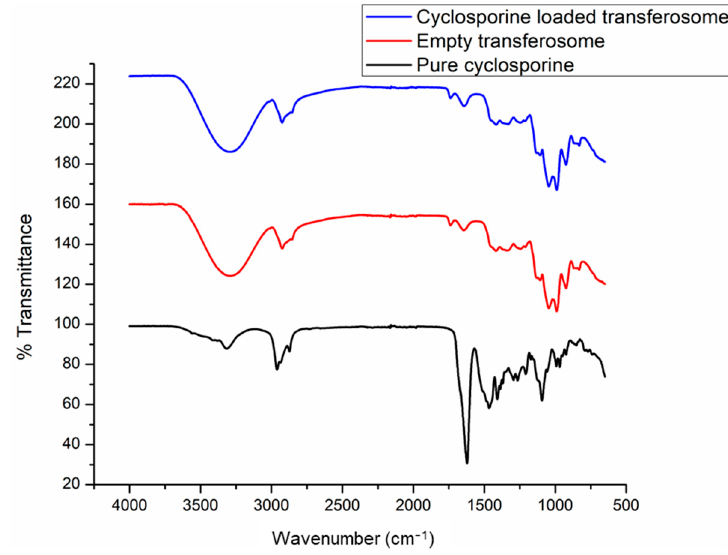
Figure 1. FTIR analysis of drug-free and drug-loaded transferosomes.